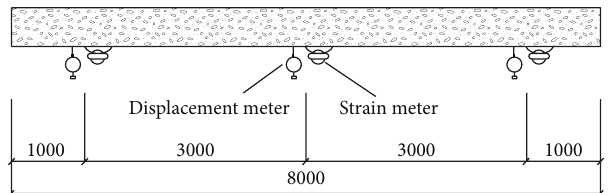
Figure 10: Layout of measurement points of deformation and strain on the test cross